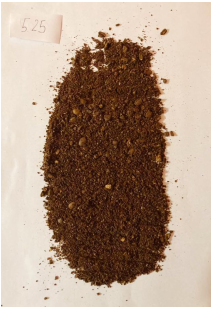
Figure 16. Coffee beans ground for about 5 s.